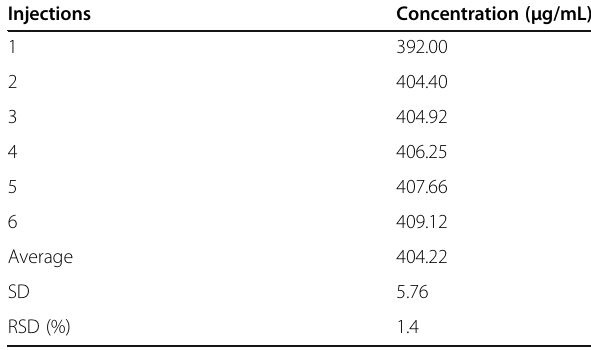
Table 3 System suitability study